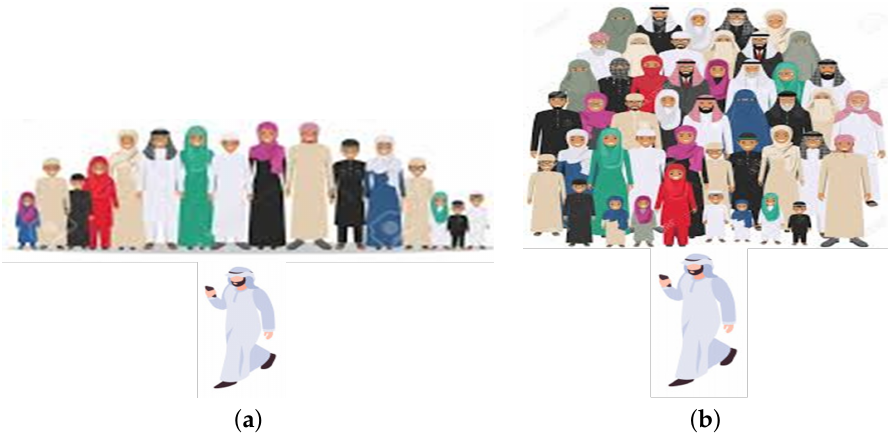
Figure 2. Groups with head/leader. ( a ) Family with head; ( b ) Group with